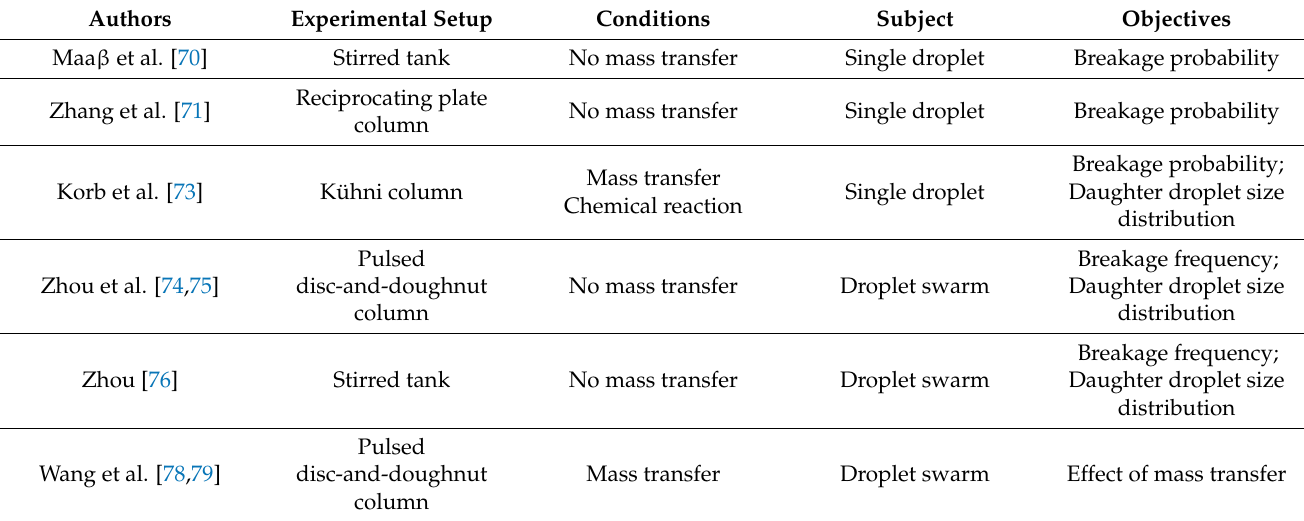
Figure 3. Statistical results of droplet breakup frequency function (DBFF) in a pulsed disc-and- doughnut column. ( a ) The DBFF at different heights under mass transfer conditions. ( b ) The DBFF at different heights for the blank experiments without mass transfer. Reprinted with permission from Ref. [78]. 2020, Wiley (John Wiley and Sons). Table 5. Studies on droplet breakage in a macroscopic